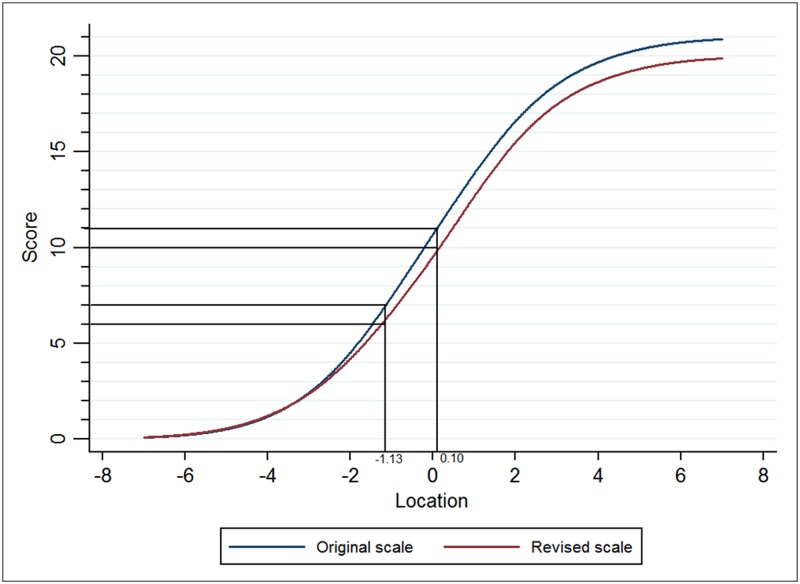
Equating tests to ascertain new cut-off scores for the HADS-D.